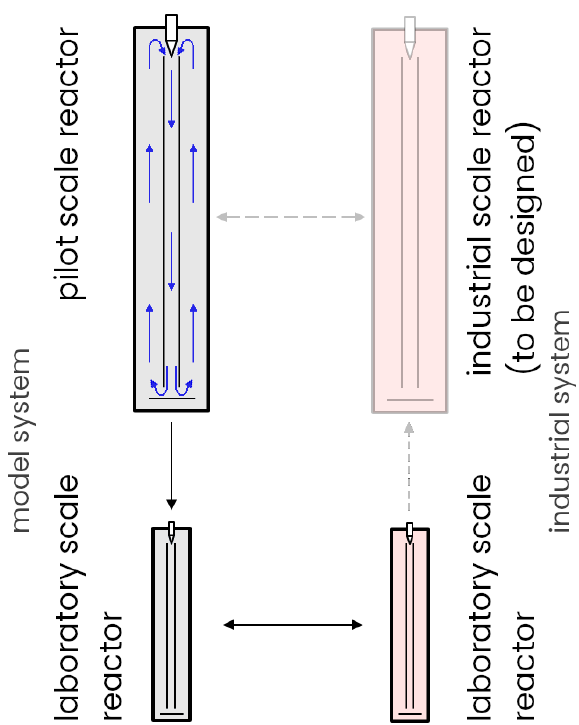
Figure 1. Schematic representation of the scale-up; investigations are conducted between the pilot and laboratory scale in the model system water/air (grey), while a comparison between water/air and the industrial system (apricot) is conducted on laboratory scale. The gathered data is used for the scale-up of the chemical process to the industrial scale. Blue arrows exemplarily denote the up- and downwards flow of the